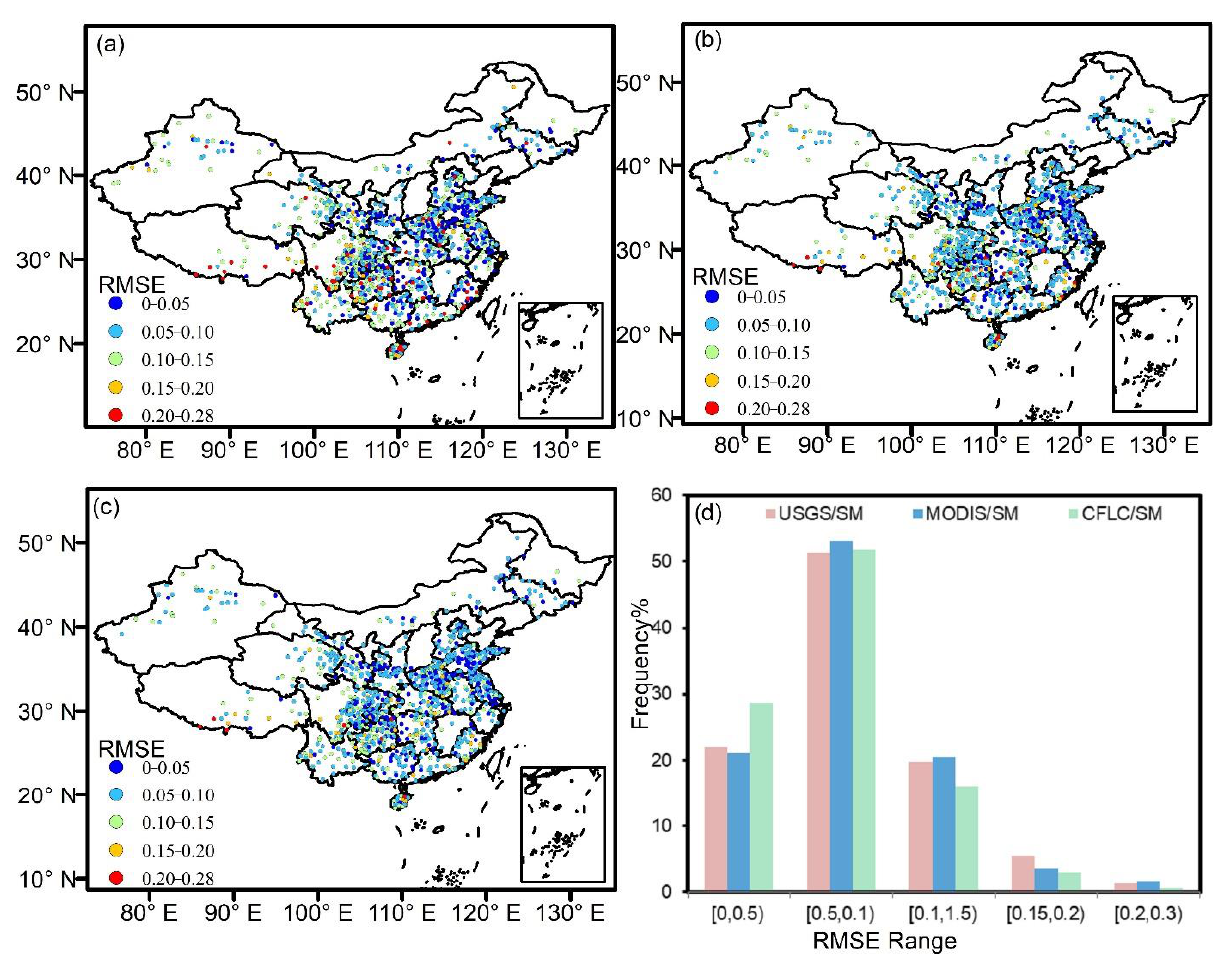
Figure 8. The spatial distribution map of the root mean square error of the daily mean soil moisture of 0 – 10 cm in 2014 simulated by Noah-MP. ( a ) The result of USGS/SM simulation. ( b ) The result of MODIS/SM simulation. ( c ) The result of CFLC/SM simulation. ( d ) The percentage of the root mean square error in different intervals.